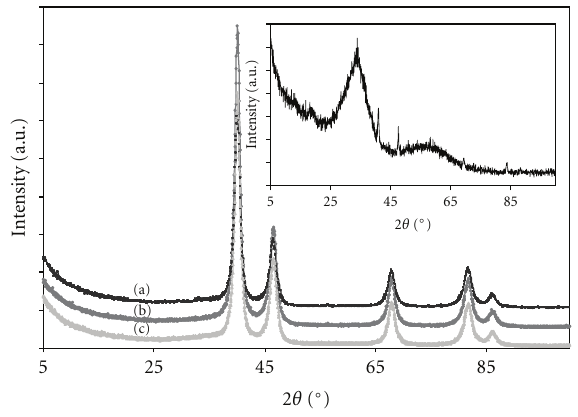
Figure 1: XRD patterns of (a) 14/86, (b) 11/89, (c) 7/93 IrO 2 /Pt catalysts, and (inset) commercial IrO 2